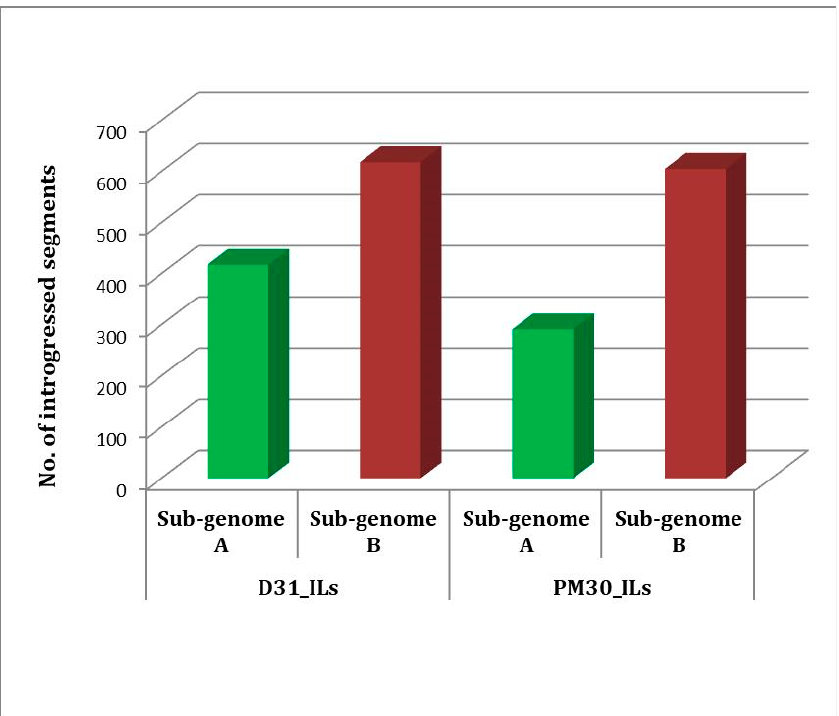
Figure 4. Introgressed segments of B. carinata into sub-genomes of B. juncea cultivars, viz., DRMRIJ 31 (D31_ILs) and Pusa Mustard 30 (PM30_ILs).